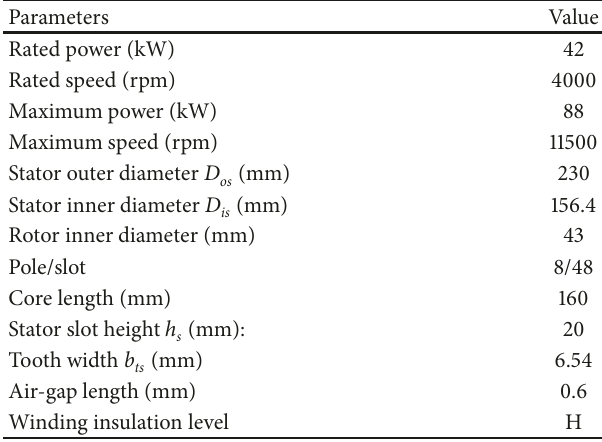
Figure 9: Measured waveform of input current at 4000r/min @88kW. Table 1: Performance and main dimensions of prototype